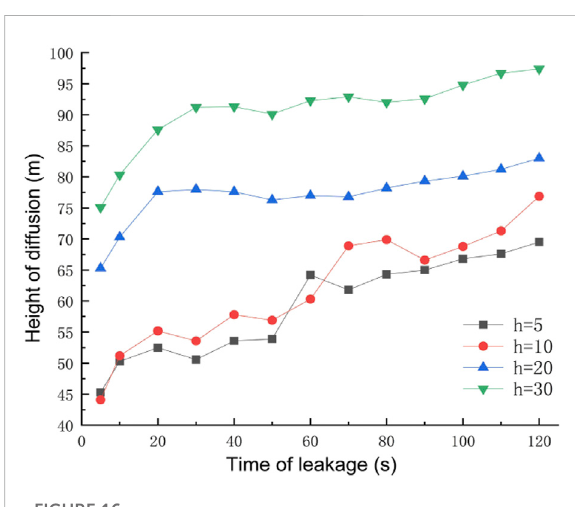
FIGURE 15 Concentration map of monitoring points under different obstacle heights after 120 s.